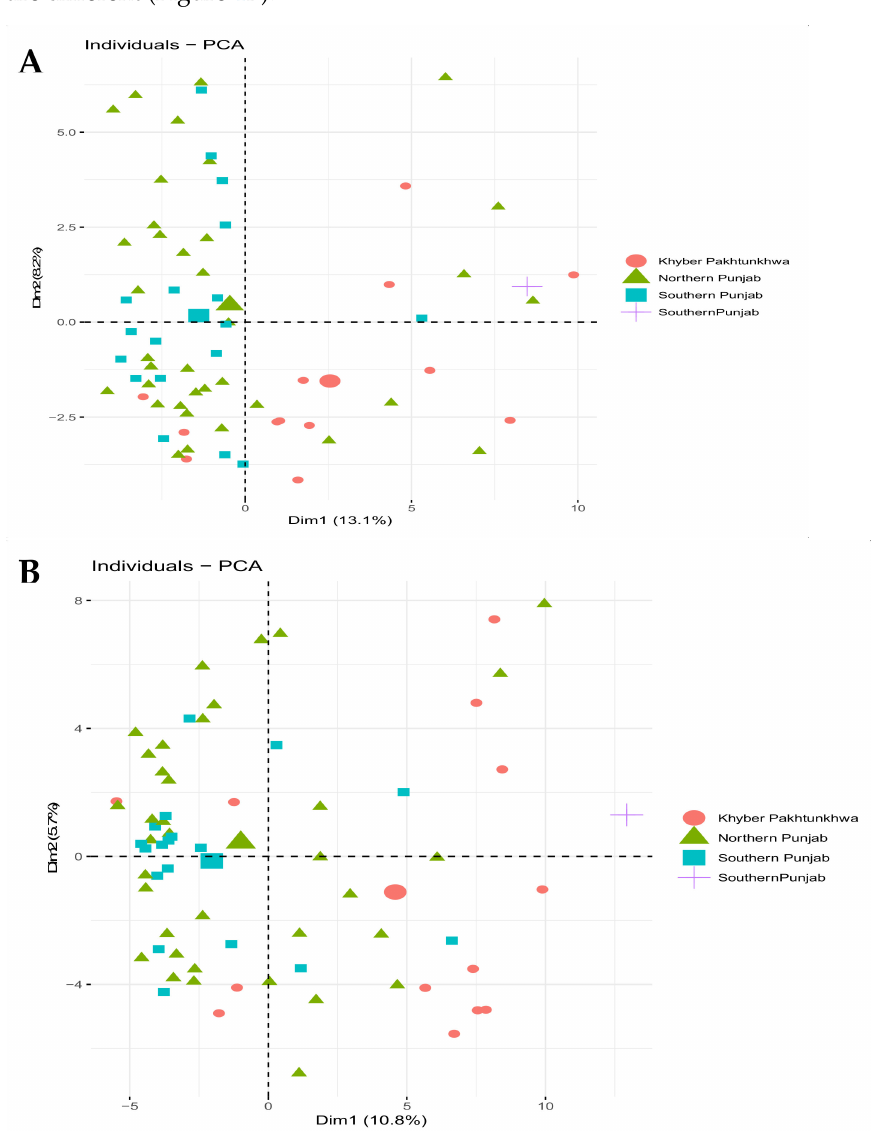
Figure 4. Distribution of T. indica isolates revealed by principal component analysis (PCA) based on ( A ) RAPD and ( B )